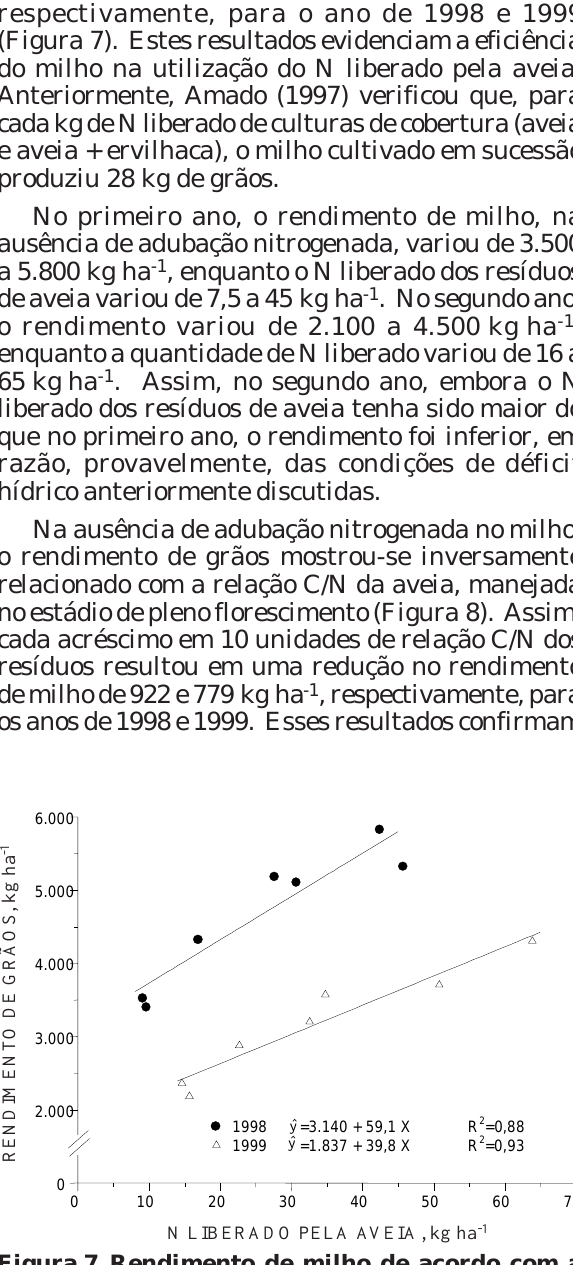
Figura 7. Rendimento de milho de acordo com a quantidade de N liberado pelos resíduos da aveia preta nos anos de 1998 e 1999.